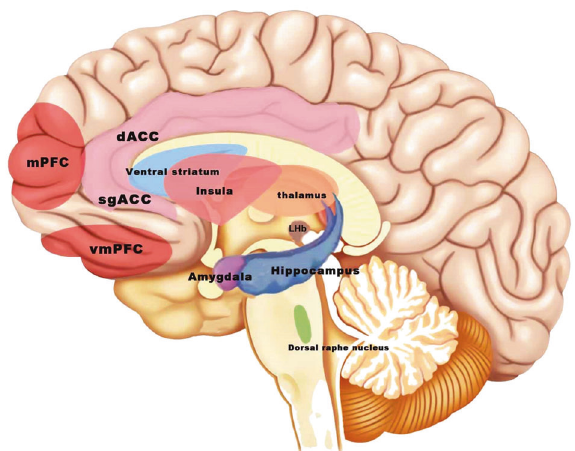
Fig. 1 Brain regions with in fl ammatory activation in the key circuits of anxiety and depression. Altered in fl ammation in the medial prefrontal cortex (mPFC), anterior cingulate cortex (ACC), amygdala, hippocampus, insula, and other brain areas has been reported in vivo PET imaging studies in humans. The lateral habenula (LHb) and the dorsal raphe nuclei (DRN), which play an important role in depression, are found to have in fl ammatory changes in animal